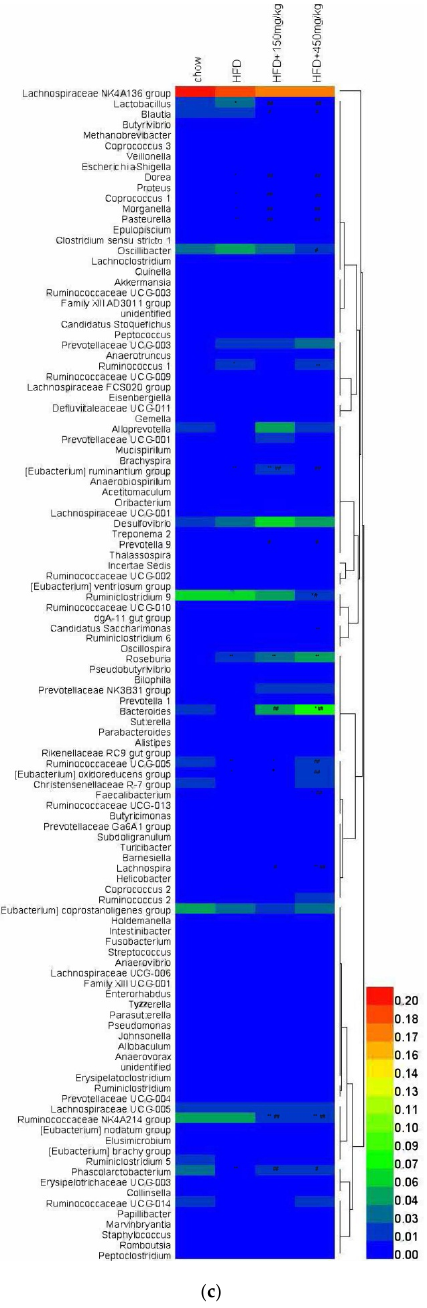
Figure 5. SIF altered microbiota composition in HFD-fed rats. ( a ) PCA score plot; ( b ) Relative abundance of several bacterial in the phylum (those with significant differences among groups); ( c ) Hierarchical clustering with a heat map shows the relative abundance of microbiota in the genus. P values were indicated as: * P < 0.05, ** P < 0.005 (* indicate versus chow group). # P < 0.05, ## P < 0.005 ( # indicate versus HFD group).